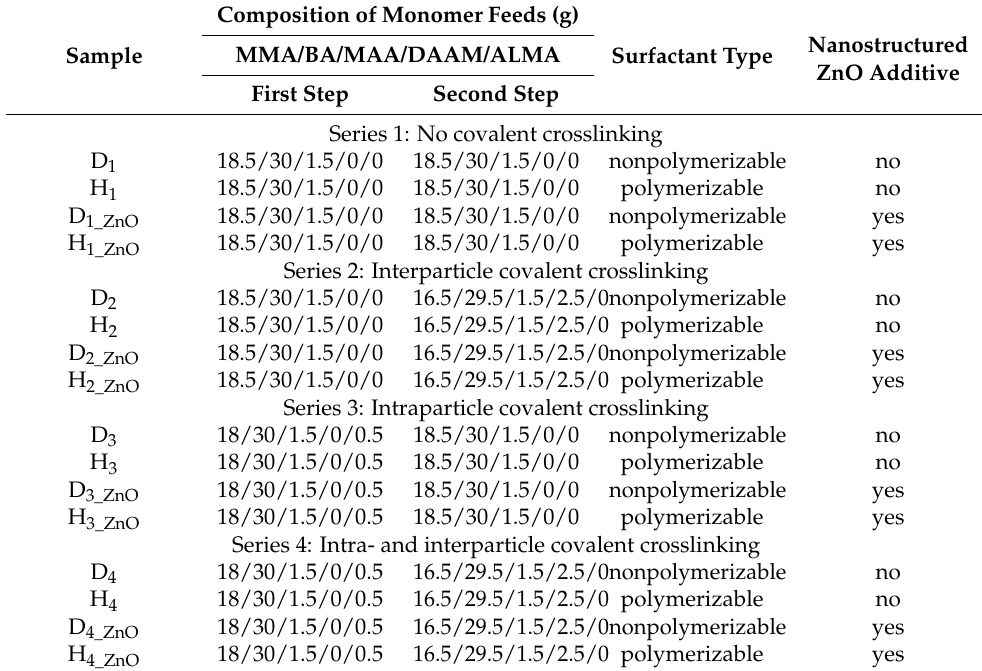
Table 2. Monomeric compositions of latexes differing in the covalent crosslinking strategy, surfactant type and the application of nanostructured ZnO additive.